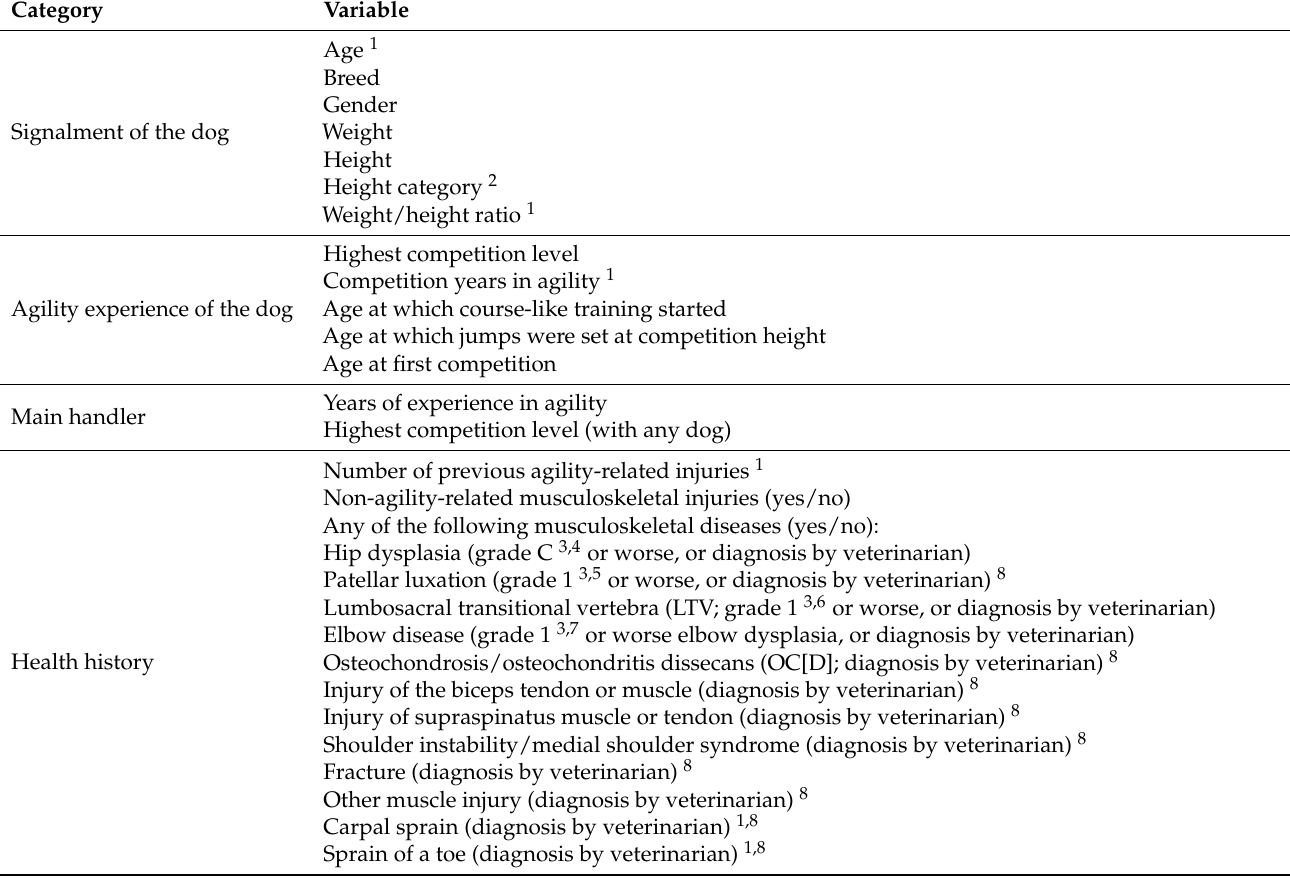
Table 1. Questions regarding demographic and background